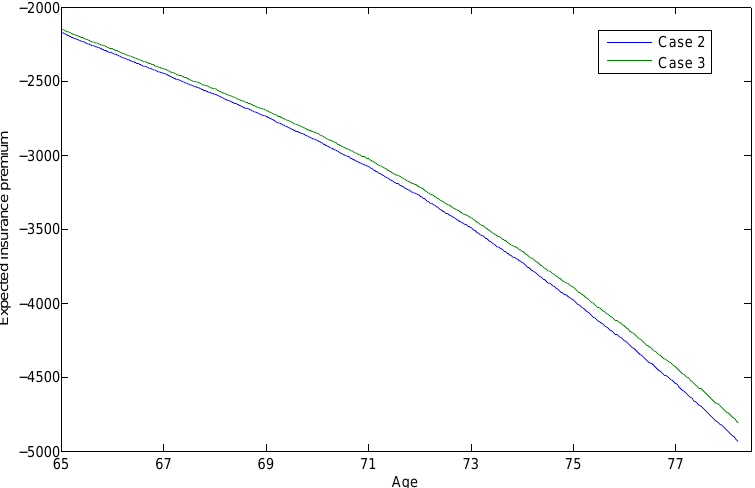
Figure 4. Expected insurance premiums paid by case 2 and case 3 agents, truncated at optimal stopping times, for those commencing at age 65 in the healthy state with a total wealth of 10 Y . Negative insurance premiums mean the agents are receiving funds from the insurers, that is, they are in receipt of an annuity.